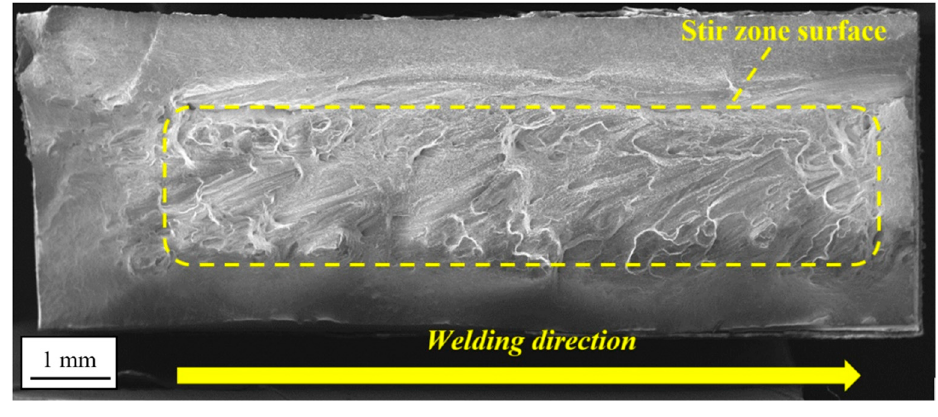
Figure 9. Fracture surface of FSW tensile sample.